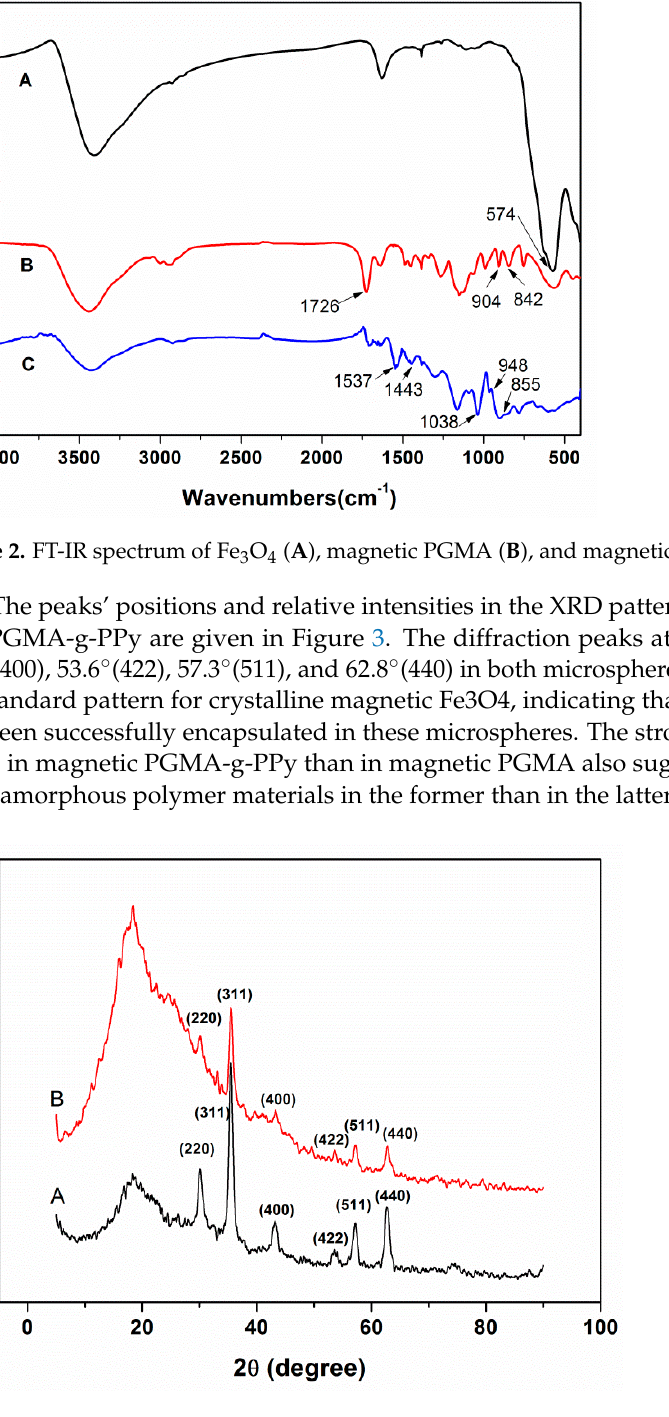
Figure 4. Magnetization curves of magnetic PGMA-g-PPy microspheres. 3.2. Material Stability In order to examine the stability of magnetic PGMA-g-PPy, the microspheres were dispersed into aqueous solutions within a pH range of 1.0–11.0 for 24 h with continuous vibration in a table concentrator, and the leaking of iron ions into the supernatant was quantified by atomic adsorption spectrometry. No iron in the supernatant was detected in the investigated pH range, suggesting that the developed adsorbents were highly stable in strongly acidic conditions for a long time. Their acidic resistance was obviously better than magnetic nanoparticles created by organic surface coating, with a leaching of 1.7– 3.7% Fe at pH 4.0–1.0 for 6 h [35]; magnetite nanoparticles created by poly (glutamic acid) coating, with a leaching of 0.001–0.9% Fe at pH 3.0–1.0 for 2 h [31]; and magnetic particles created by thin-polystyrene-chain coating, with a leaching of 0.3–3% Fe in acidic condi- tions [36]. This is attributed to the thick, tight polymer-network protective coating pro- vided by the PGMA polymer cross-linking with the cross-linking agent.